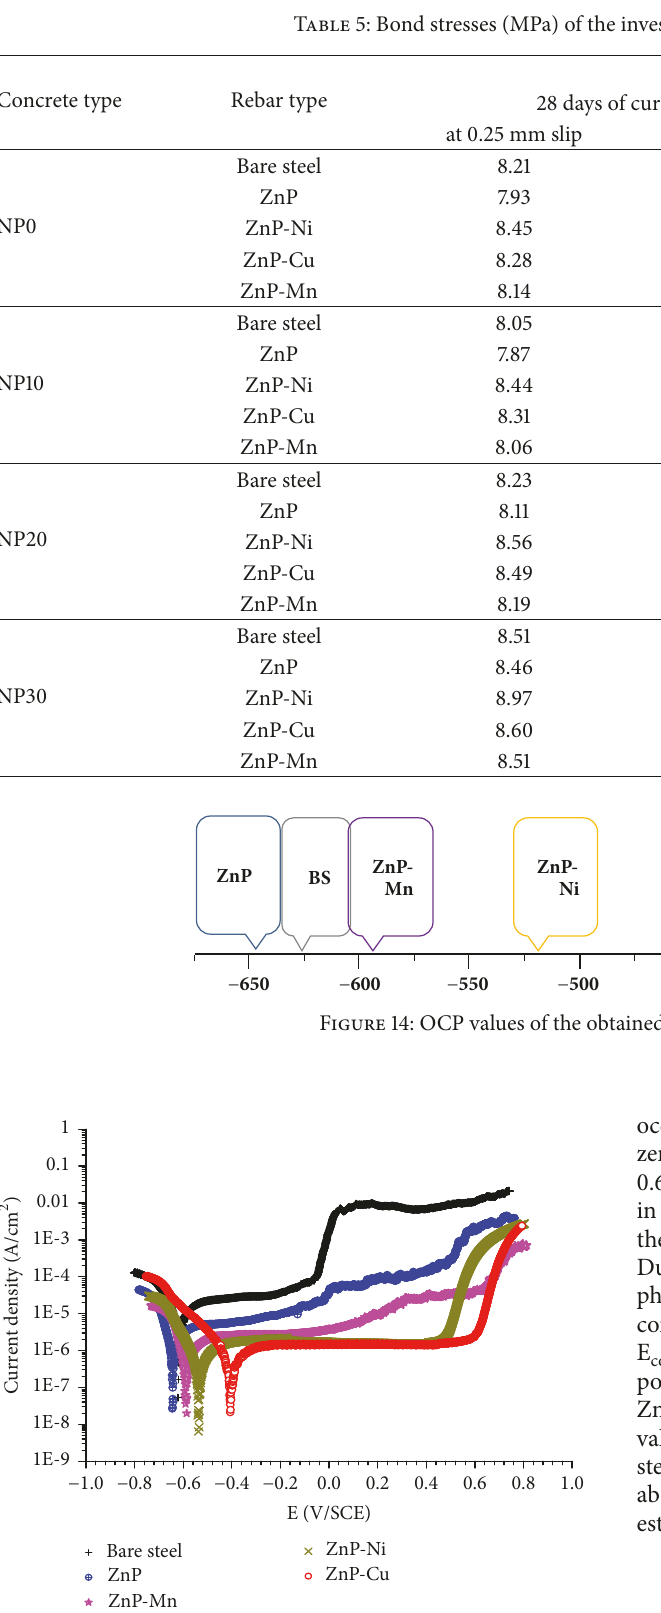
Table 5: Bond stresses (MPa) of the investigated phosphate steel rebars.